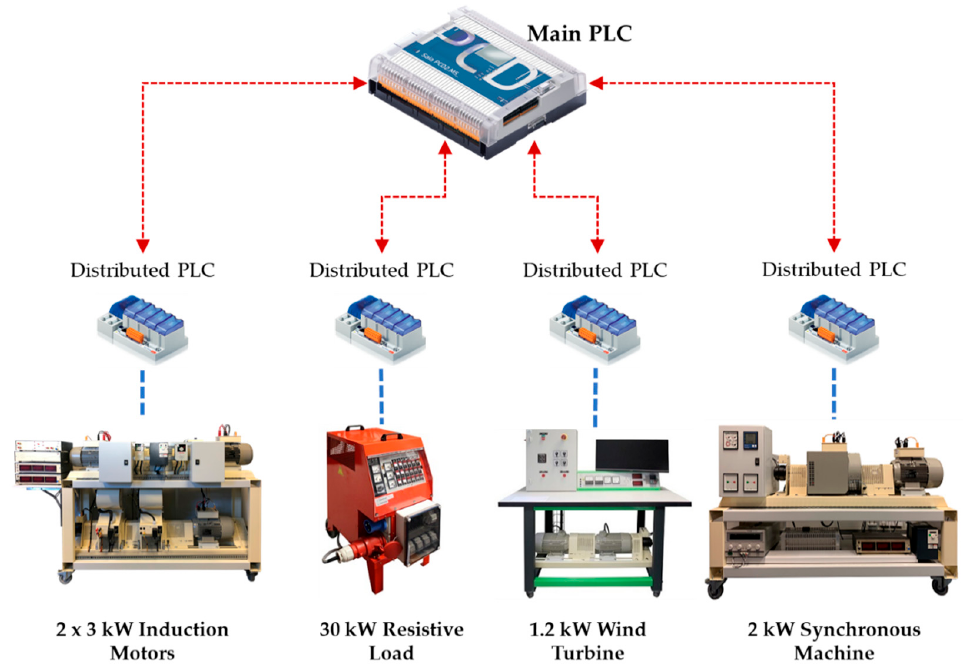
Figure 8. Architecture of the implemented model for ramping of the DR program.